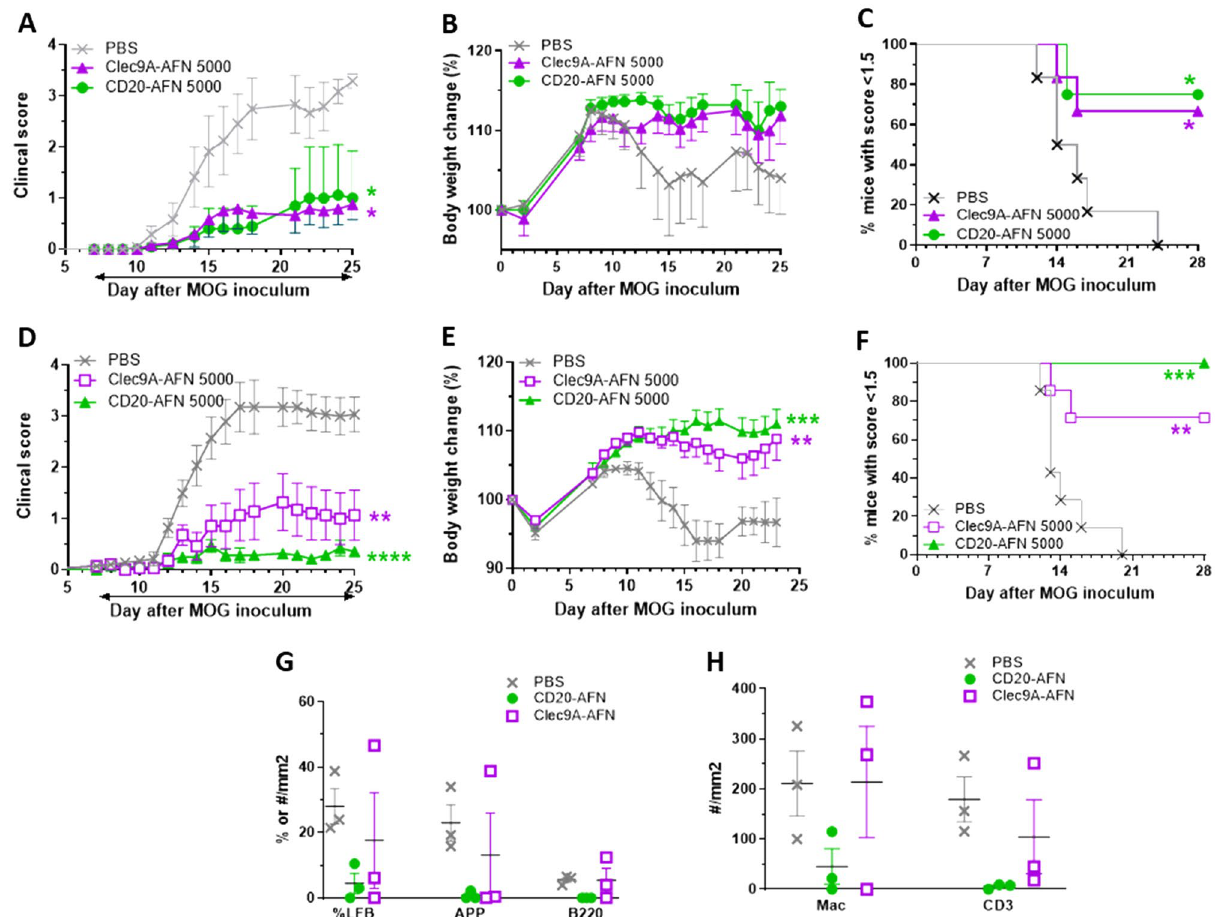
Figure 1. CD20-AFN protects at least as efficient as Clec9A-AFN against EAE progression. Shown are clinical scores ( A , D ), body weight ( B , E ), % of diseased mice ( C , F ) and spinal cord analysis ( G , H ) to evaluate demyelination (LFB), axonal damage (APP), B cells (B220), macrophages (Mac) and T cells (CD3). Shown are representative experiments [n = 6–7 for ( A – F ), n = 3 for ( G , H )]. The black horizontal arrow indicates the daily treatment period, starting on d7, with 5000 IU AFNs. Differences were assessed using two-way ANOVA followed by Dunnett’s multiple-comparison test ( A , B , D , E ), or using Chi Square Log-Rank test for the Kaplan– Meier plots ( C , F ); *P < 0.05, **P < 0.01, ***P < 0.001, ****P < 0.0001, compared with PBS treated